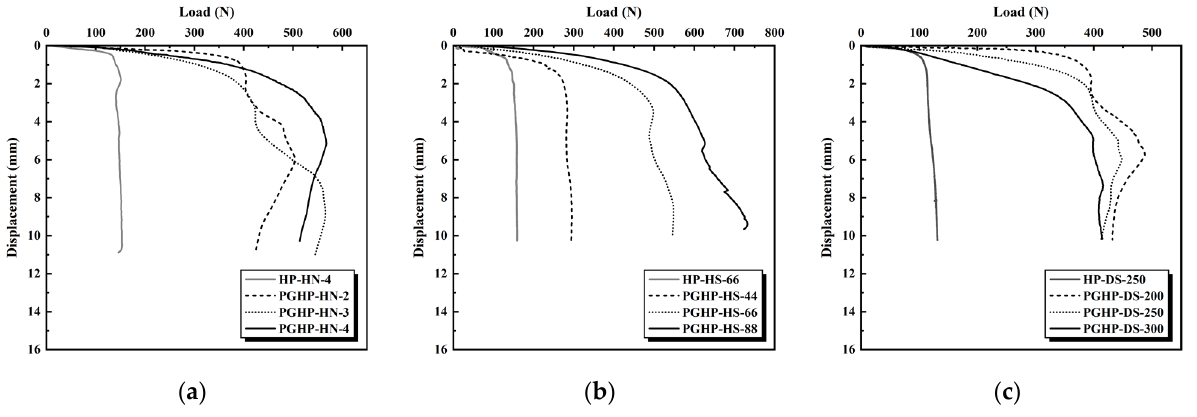
Figure 12. Load–settlement curves of compression: ( a ) helix number test sets, ( b ) helix size test sets, and ( c ) drilling speed test sets.